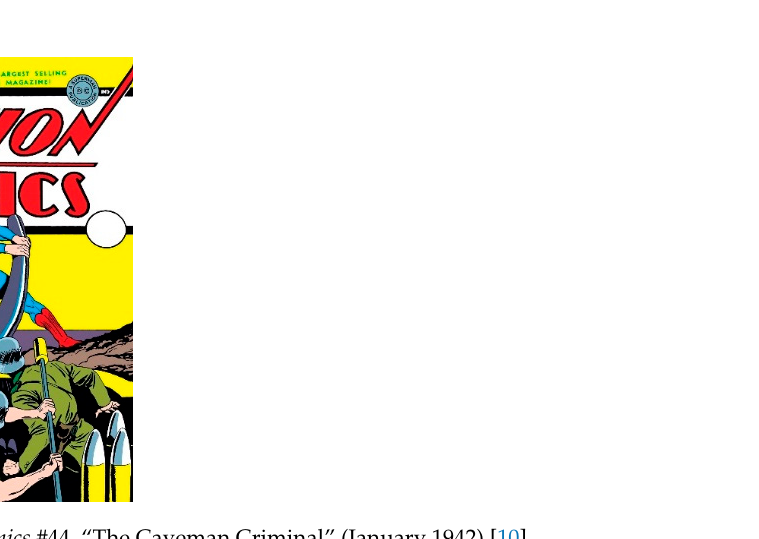
Figure 1. Action Comics #44, “The Caveman Criminal” (January 1942) [10] .